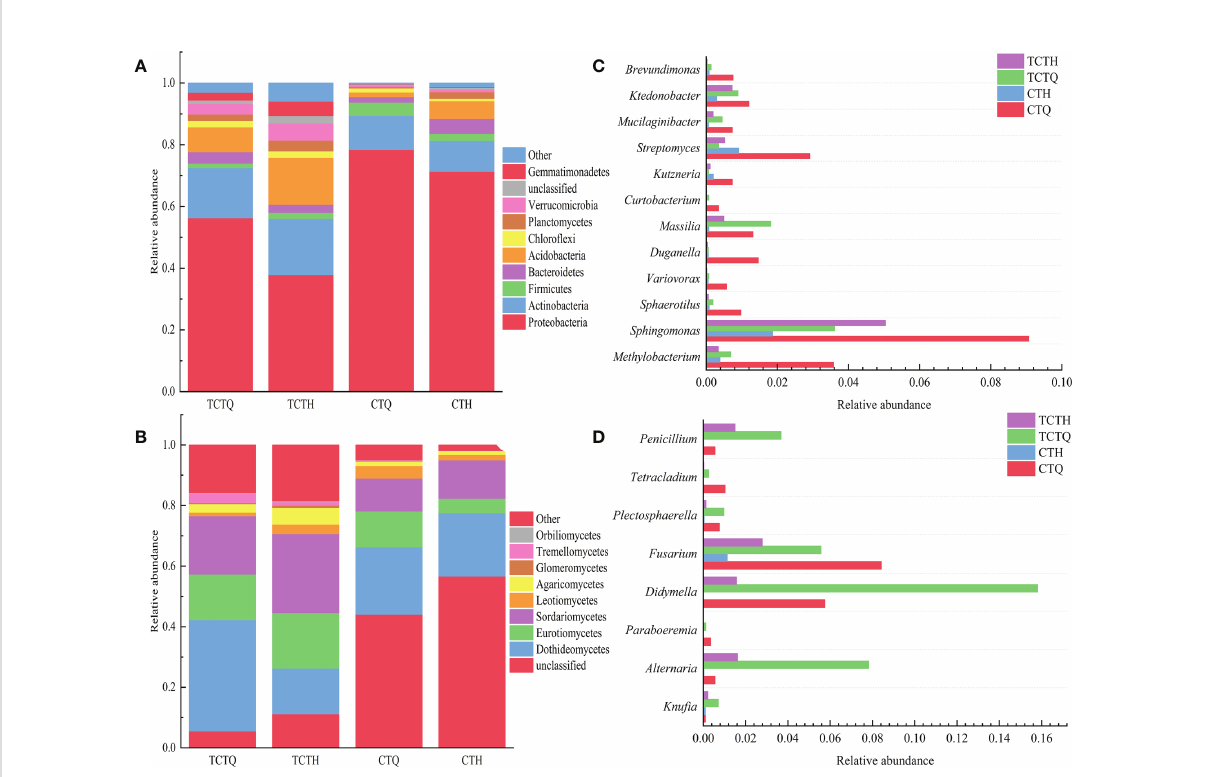
FIGURE 4 Taxonomic composed of bacterial and fungal microbiomes. (A) Bacterial community composition in the pre-and post-bolting stages of Qianhu; (B) Fungal community composition; (C) Comparison of bacterial communities that decreased after bolting as screened by LEfSe analysis; (D) Comparison of fungal